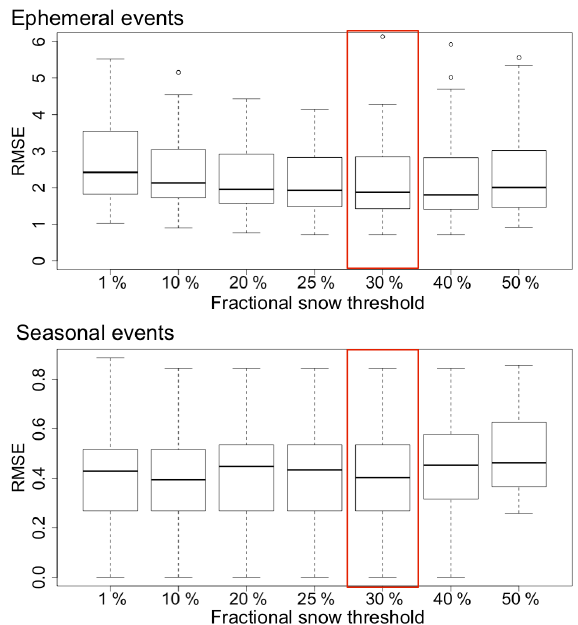
Figure A4. Box plots depicting the root mean square errors between the number of observed ephemeral and seasonal snow events at Snow Telemetry (SNOTEL) stations and the number of ephemeral and seasonal snow events derived from the algorithm in Google Earth Engine in each 500m MODIS pixel corresponding to that station at snow fractions of 1–50%. The chosen snow fraction was 30% (highlighted in